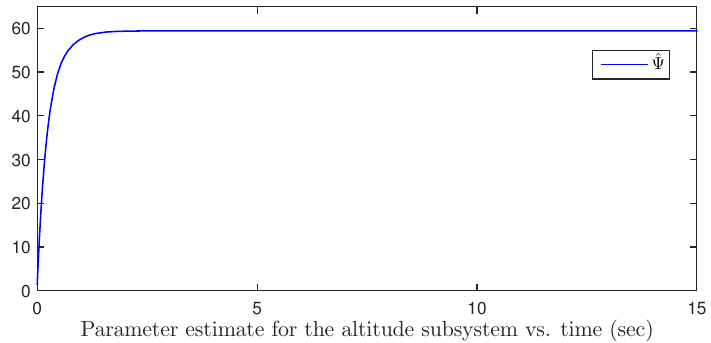
Figure 5. The parameter estimate response of the altitude subsystem.